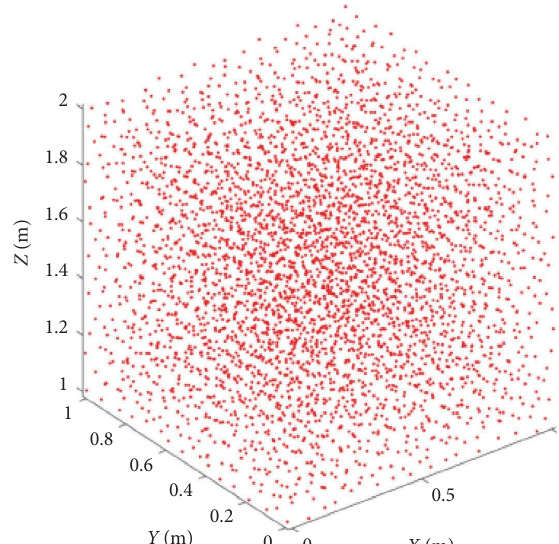
Figure 8: Nodes after random movement.